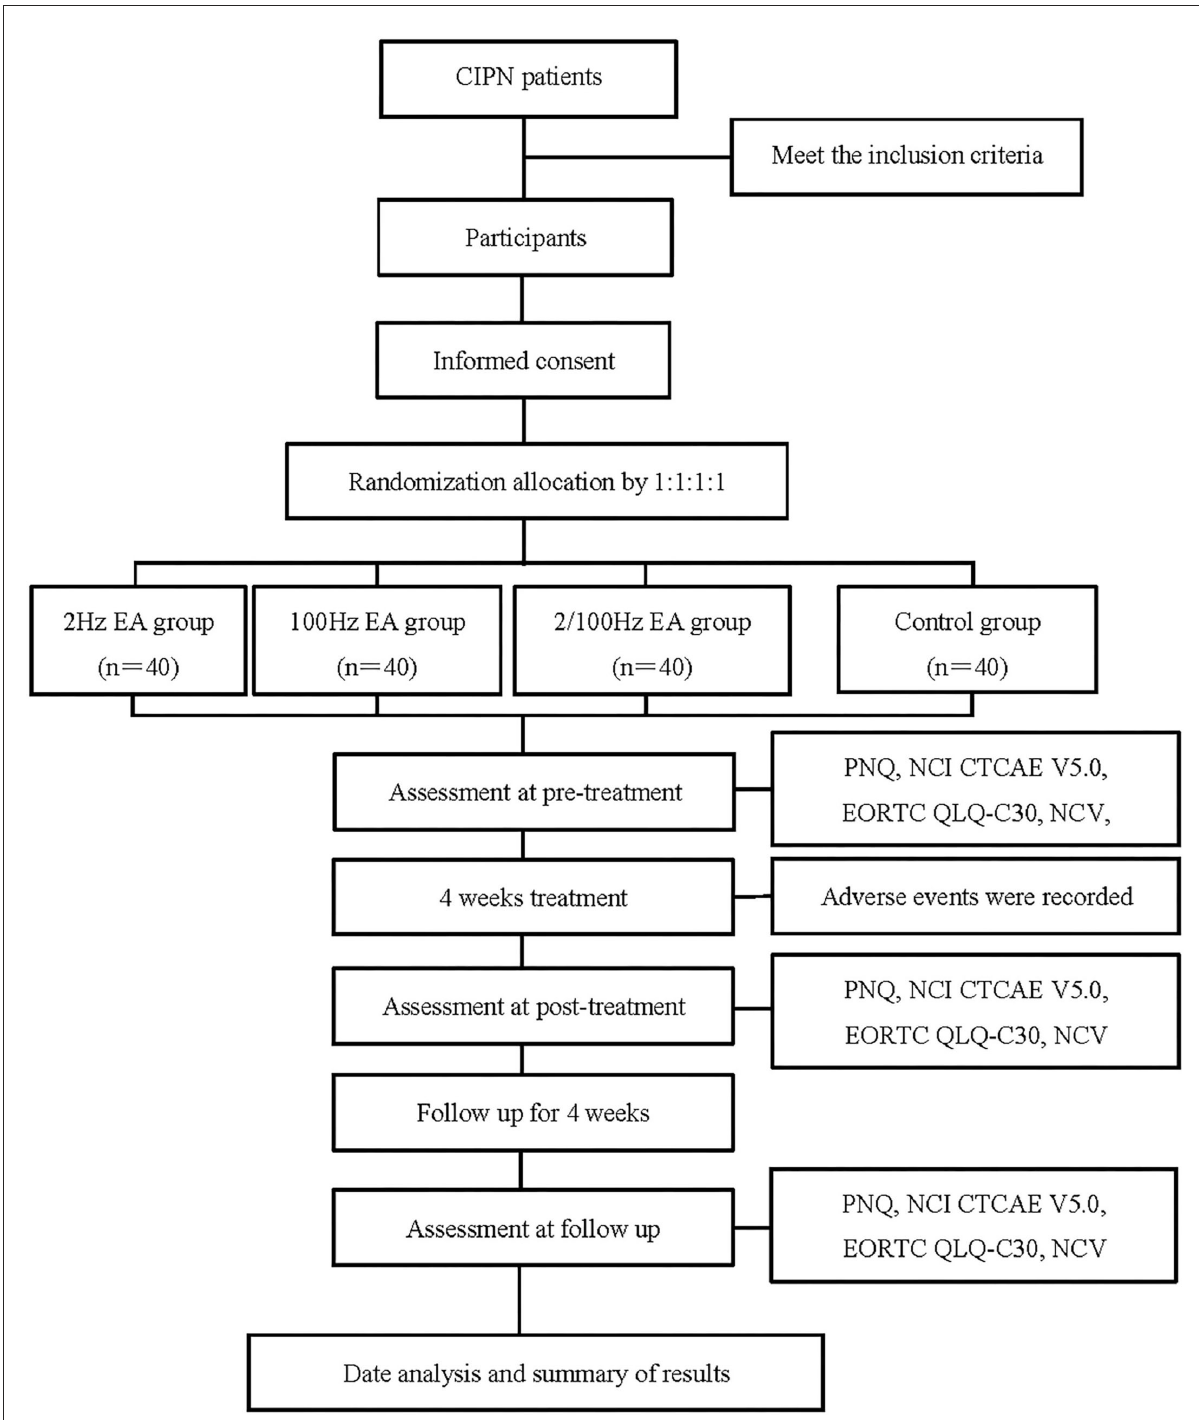
FIGURE1 Flow chart of the study process. CIPN, Chemotherapy-induced peripheral neuropathy; EA, Electroacupuncture; PNQ, The Participant Neurotoxicity Questionnaire; NCI CTCAE V5.0, National Cancer Institute Common Terminology Criteria for Adverse Events Version 5.0; EORTC QLQ-C30, The European O-rganization for Reasearch and Treatment of Cancer, Quality of Life Questionnare-Core 30; NCV, Nerve Conduction